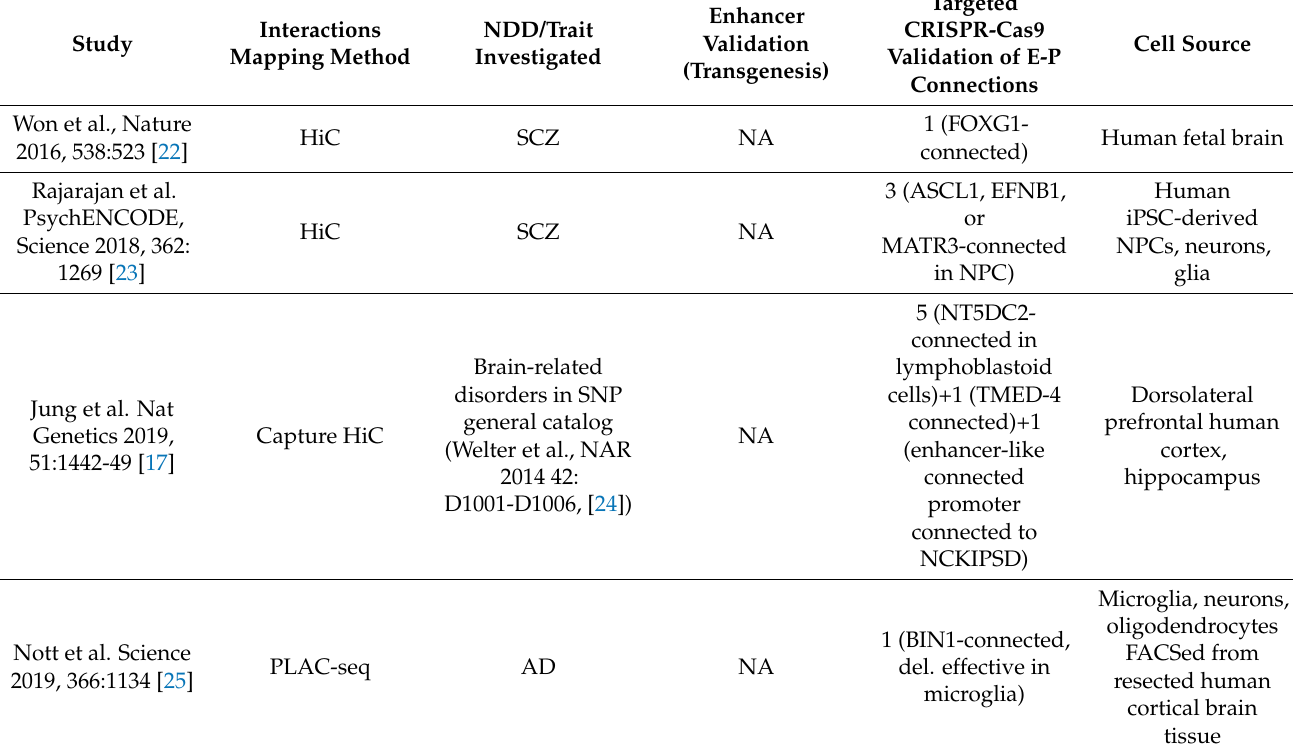
Table 1. Studies linking NDD to enhancer variants and their interacting